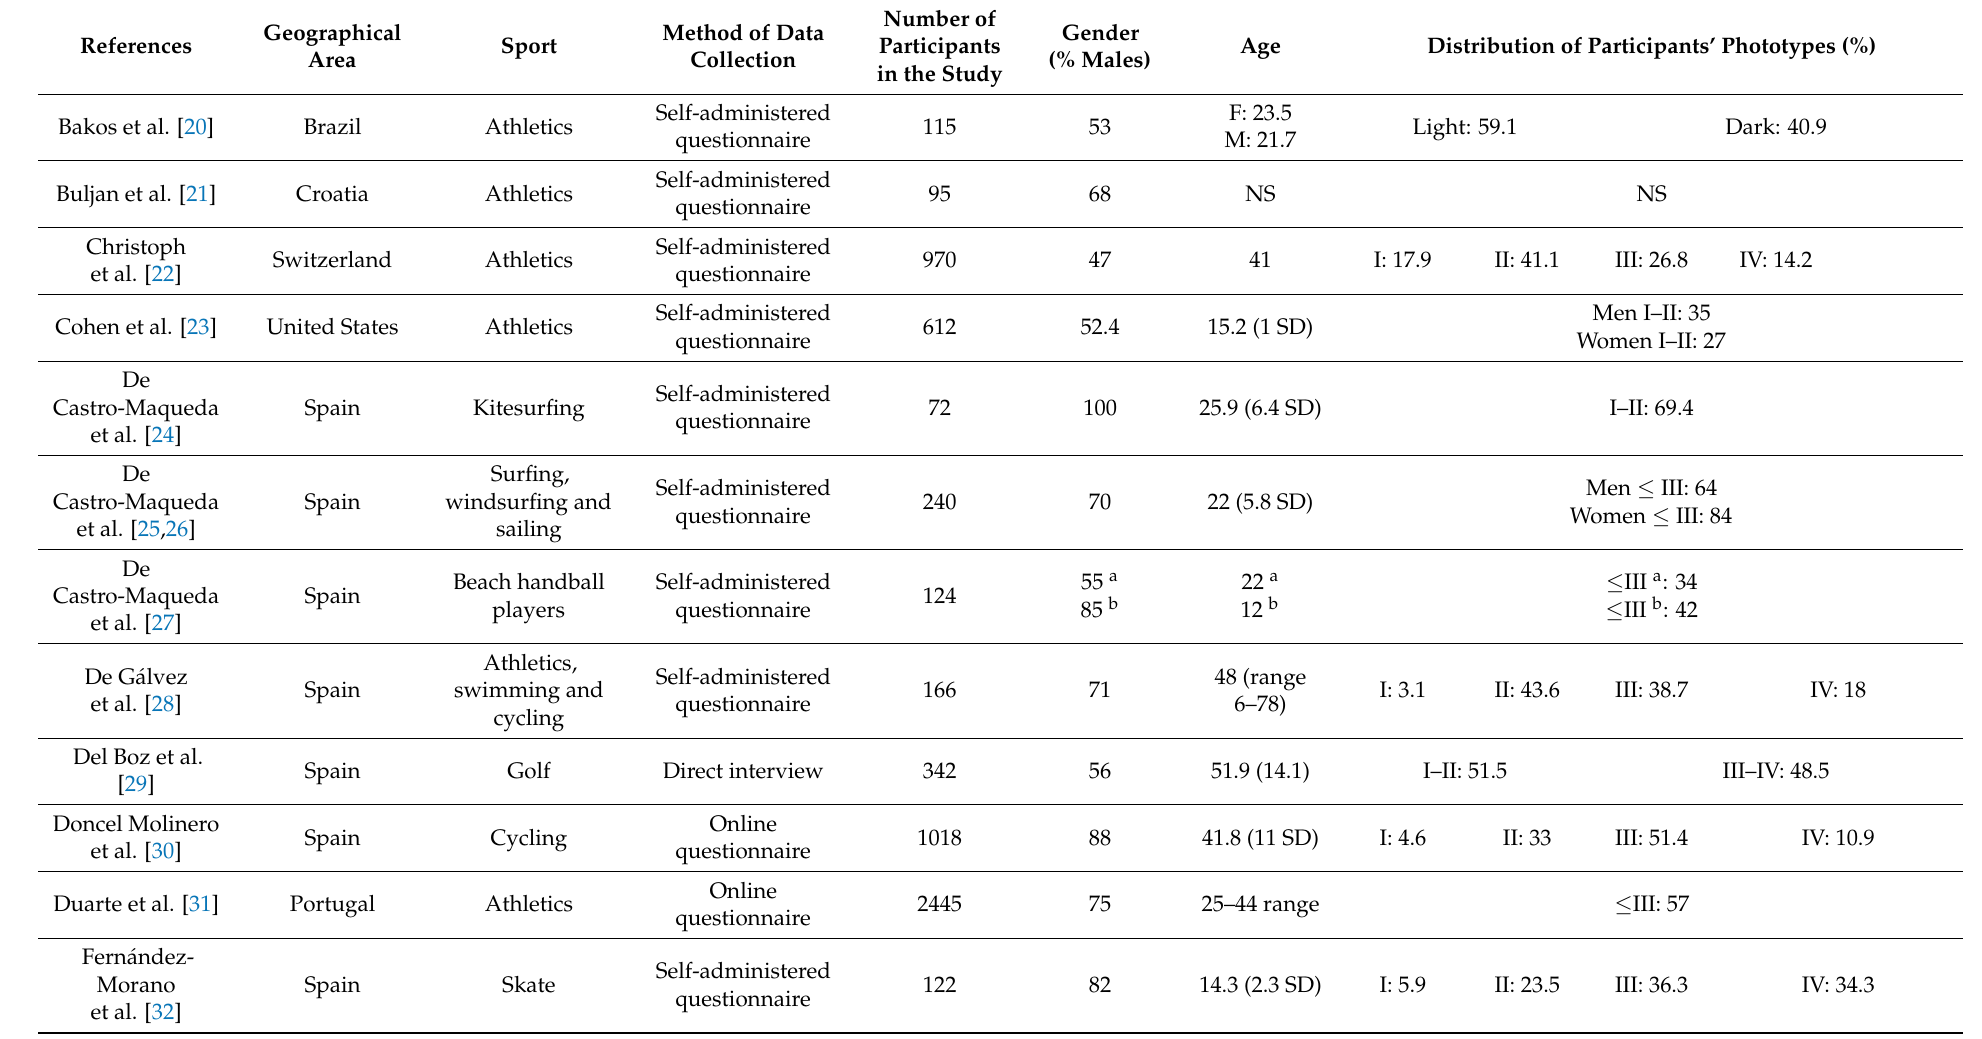
Table 1. Demographic characteristics of the